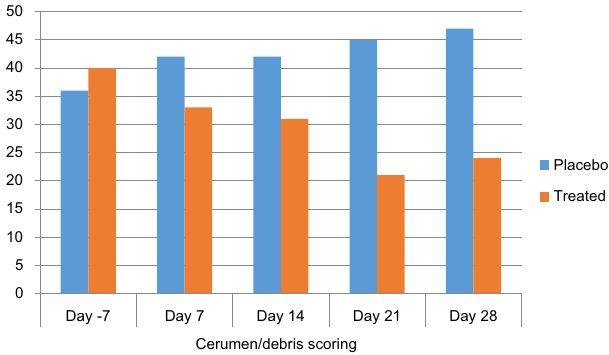
Figure 2. Debris/cerumen scoring in Lab #1. Sum of individual otoscopical scores of debris/cerumen inclusive of both ears of each cat per group ( n =